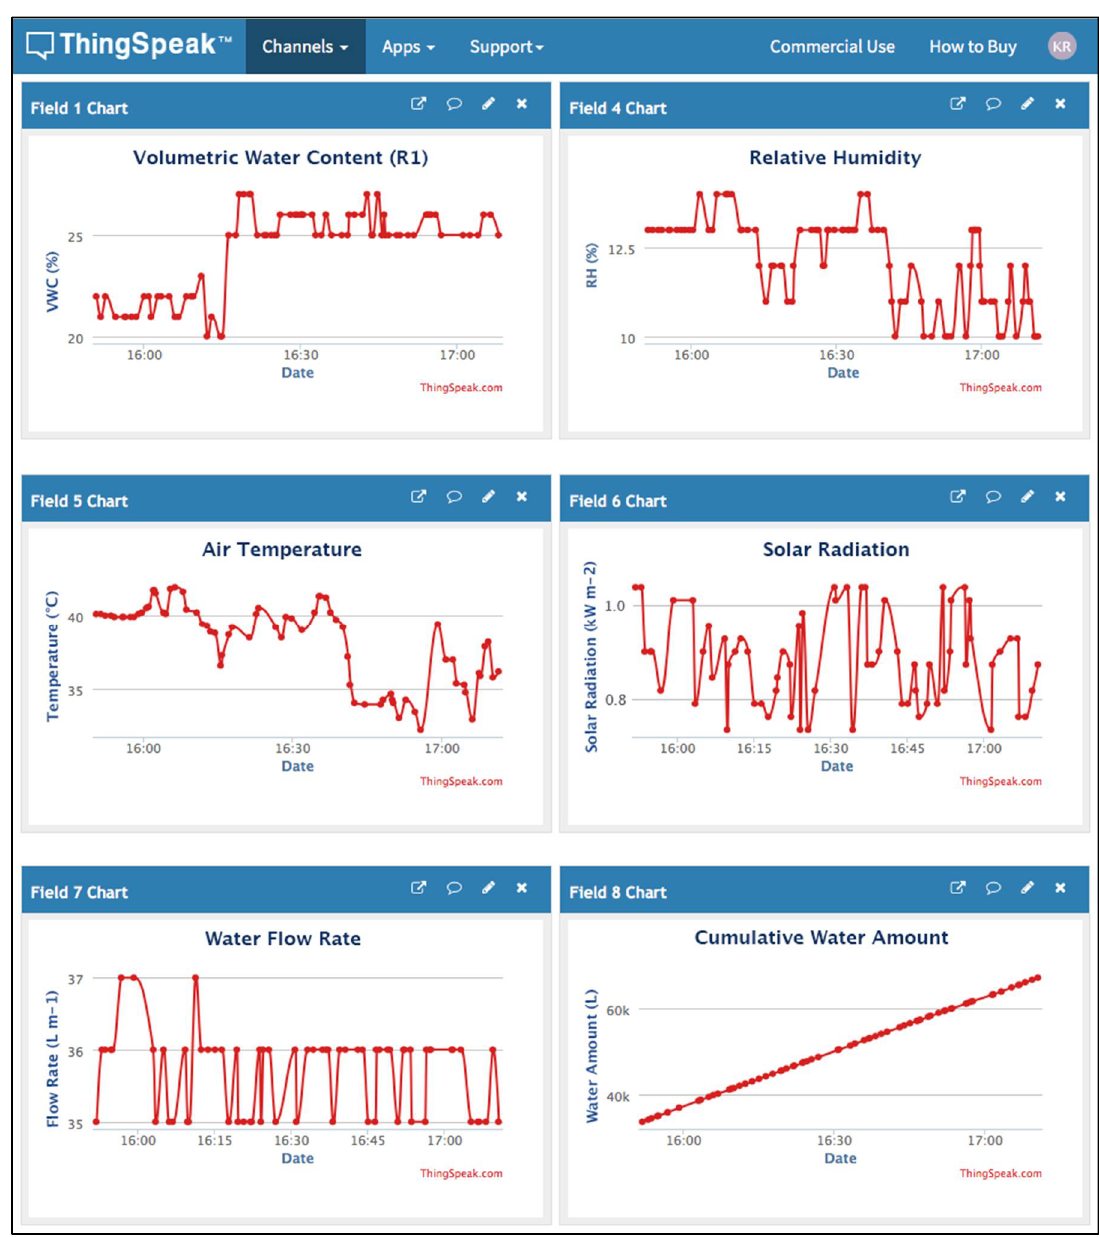
Figure 9. Some fields from our private channel on the ThingSpeak cloud platform. It represents users’ monitoring inter- face.